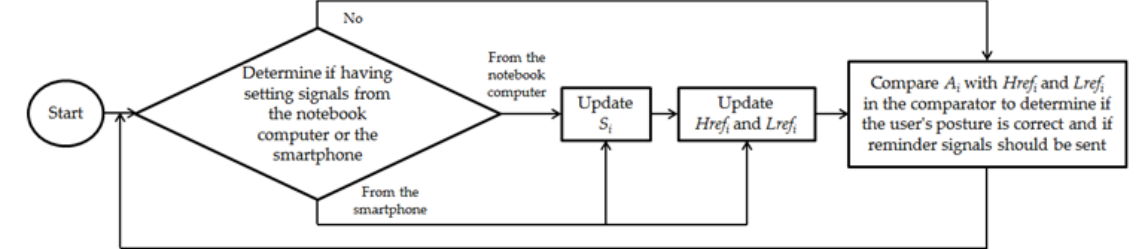
Figure 6. Flowchart describing the posture assessment performed by the smart necklace.